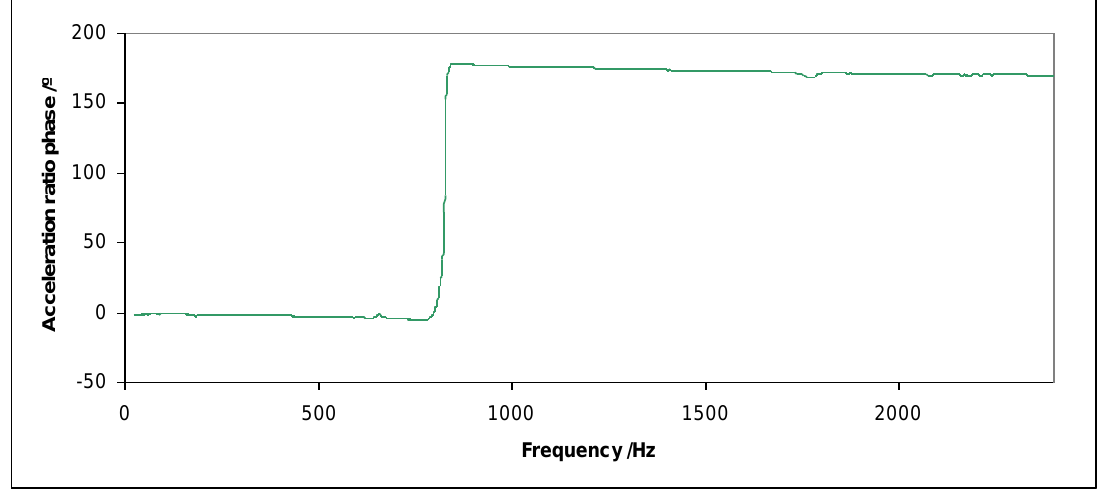
Figure 3. Acceleration ratio phase for the Kistler 9175B sensor (12.3 kg loading